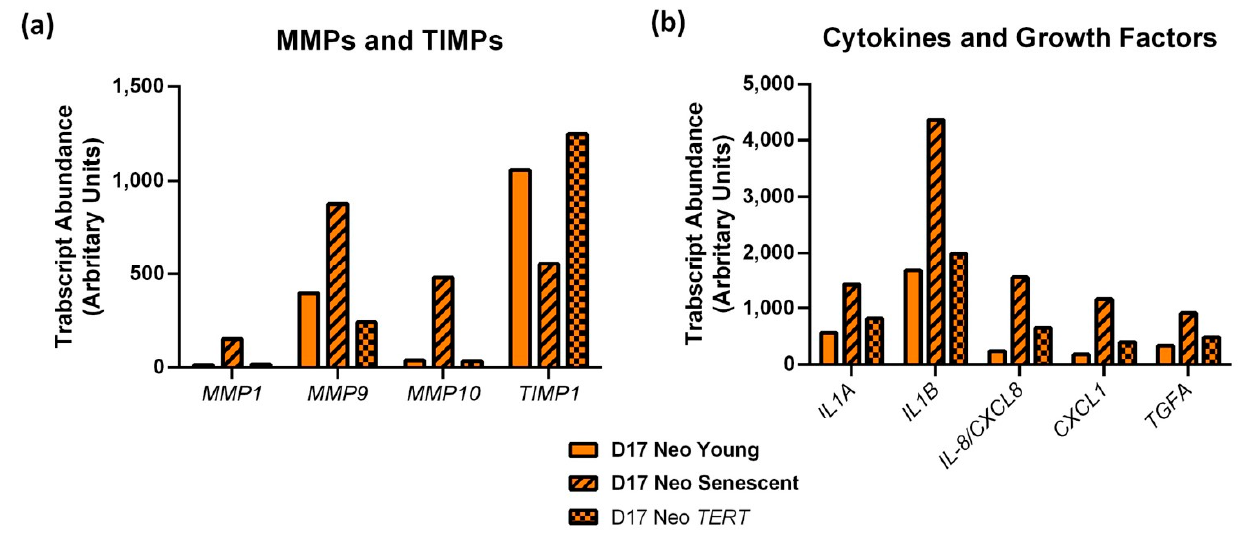
Figure 7. Senescent p16 INK4A − / − deficient D17 cells (Striped bars) show elevated SASP factors regulated by telomerase (Dotted bars). ( a ) Shows MMP and TIMP transcripts regulated by senescence and telomerase in D17 and ( b ) shows the cytokine and growth factor transcripts regulated in the same experiment as ( a ). Data mined from the microarray study in reference [10].